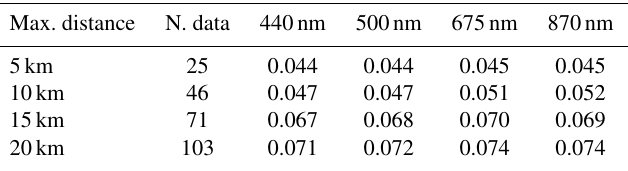
Table 5. Rms difference between RSP and AERONET in the AOTs retrieved using the Phillips–Tikhonov scheme initialized by neural network at four wavelengths, as a function of the maximum tolerated distance for co-location. Max. distance